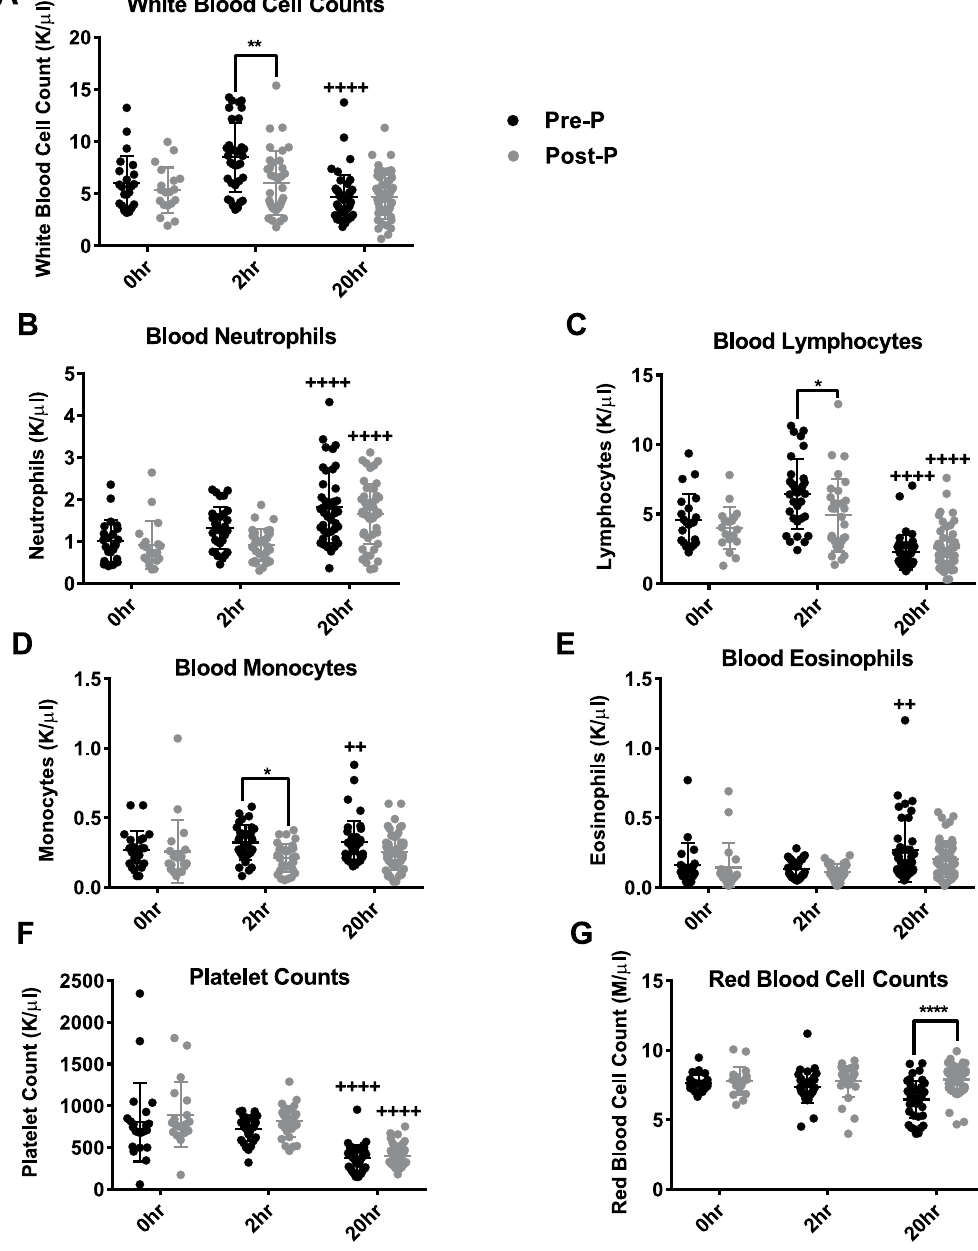
Figure 2. Pre- and post-pubertal whole blood cell counts during endotoxemia. Blood was obtained from pre- and post-pubertal (Pre-P, Post-P) C57Bl/6 mice via cardiac puncture and treated with K 2 EDTA to prevent clotting. All counts for total (A) white blood cells, (B) neutrophils, (C) lymphocytes, (D) monocytes, (E) eosinophils, (F) platelets, and (G) red blood cells and were obtained using the Hemavet 950 blood analyser. N ≥ 19/group at 0hr, N ≥ 35/group at 2 hr, and N ≥ 46/group at 20 hr. Significant changes in cell counts between 2 and 20 hours for either pre- or post-pubertal mice are labelled with ++++ (p < 0.0001) or ++ (p < 0.01). Significant differences in cell counts between pre- and post-pubertal mice are labelled with **** (p < 0.0001), ** (p < 0.01), or * (p < 0.05). All comparisons were made using Two-way ANOVA followed by Tukey’s multiple comparisons